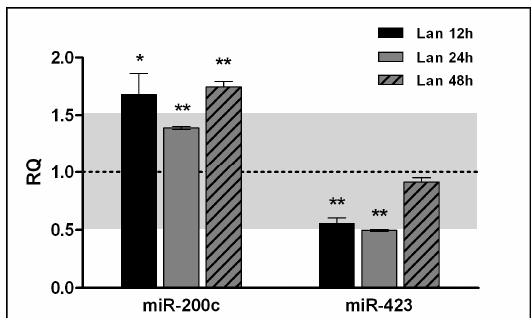
Figure 3. Effect of lanthionine on microRNAs in endothelial cells. Fold changes in miR-200c and miR-423 levels after 12 h, 24 h and 48 h of treatment with 0.3 µ M lanthionine in endothelial cells. Untreated control; dashed baseline. The gray area behind the dashed baseline, corresponding, on the y axis, to RQ 0.5–1.5, indicates an area of variations of microRNA levels which may be considered physiological with respect to the control. The columns represent the mean and error bars indicating the SD from three independent experiments; p values versus untreated control = * p < 0.05, ** p < 0.01 (according to Student’s t- test).